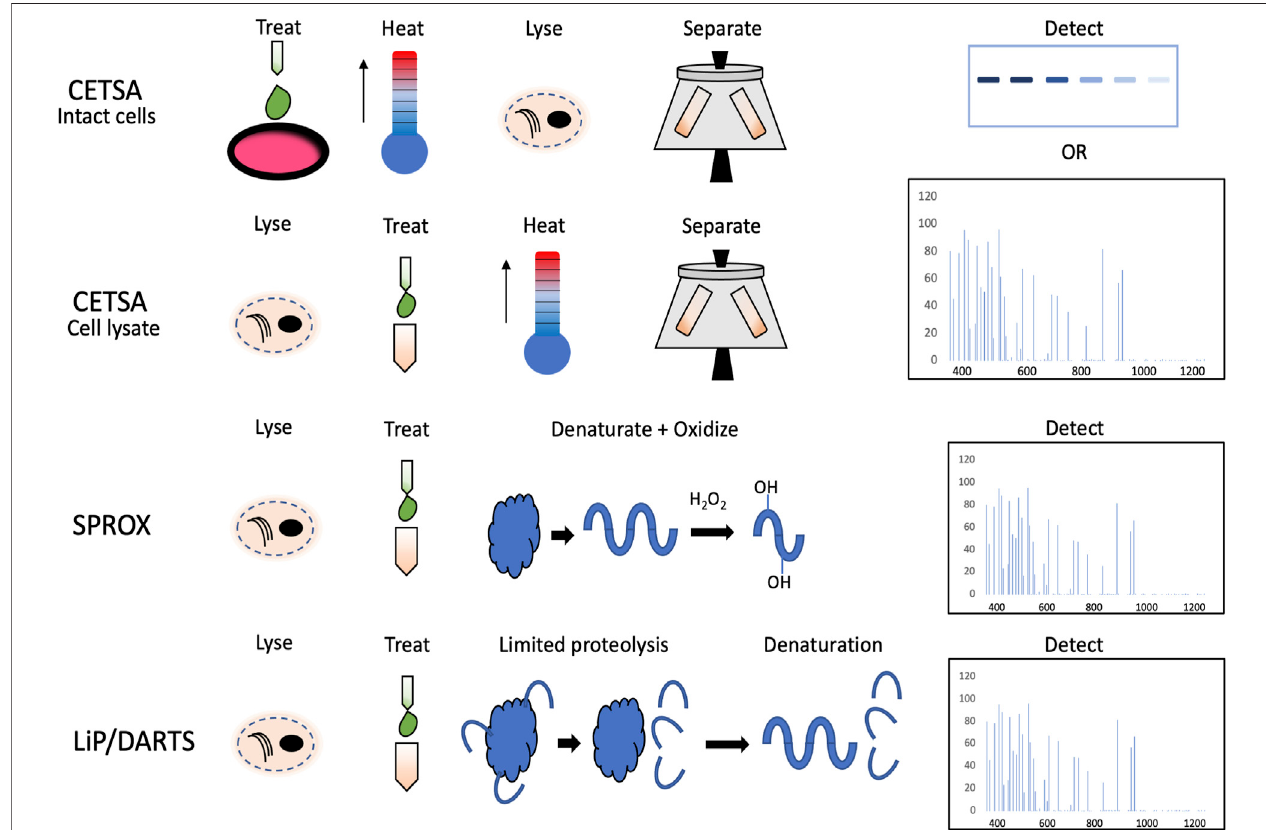
FIGURE 1 | Schematic overview of the work fl ows in CETSA performed on intact cells and cell lysates, SPROX, and limited proteolysis (LiP).